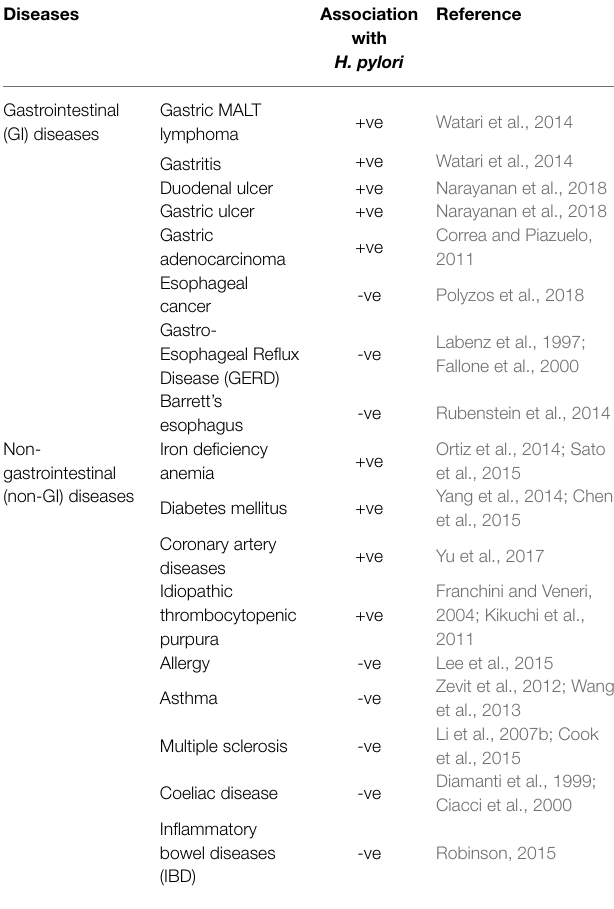
TABLE 1 | Correlation between H. pylori colonization and various disease